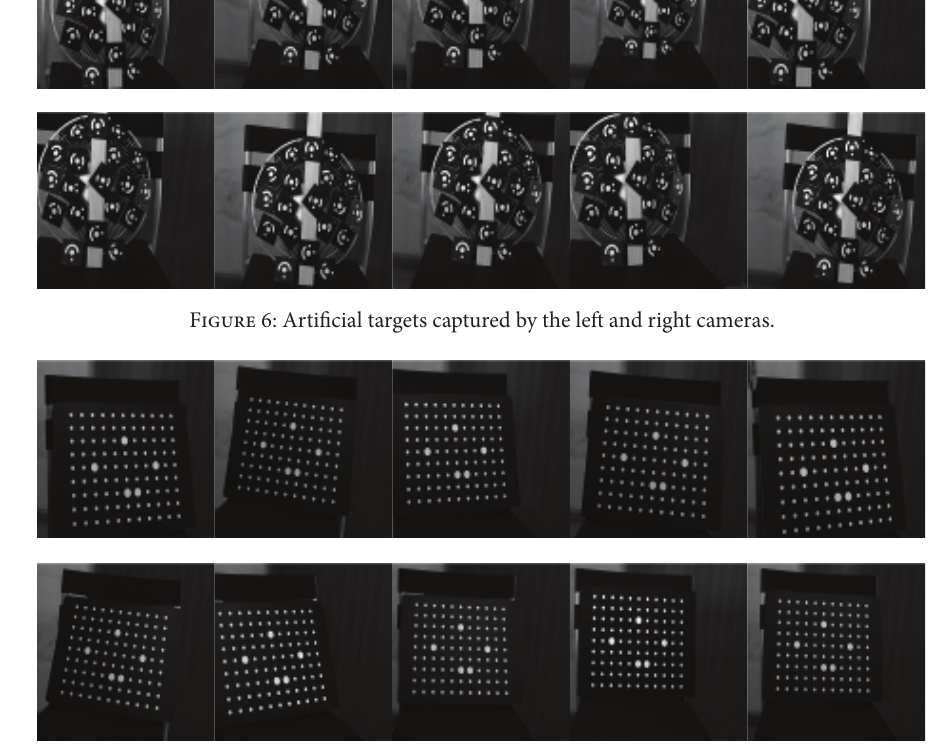
Figure 7: Panel board in Zhang’s method captured by the left and right